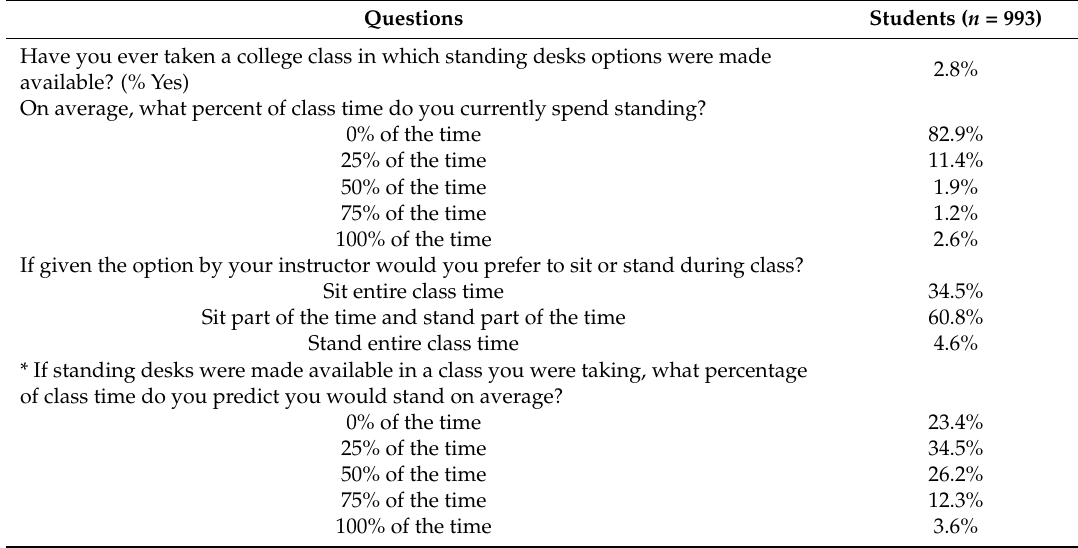
Table 2. Student’s perceived acceptability of standing